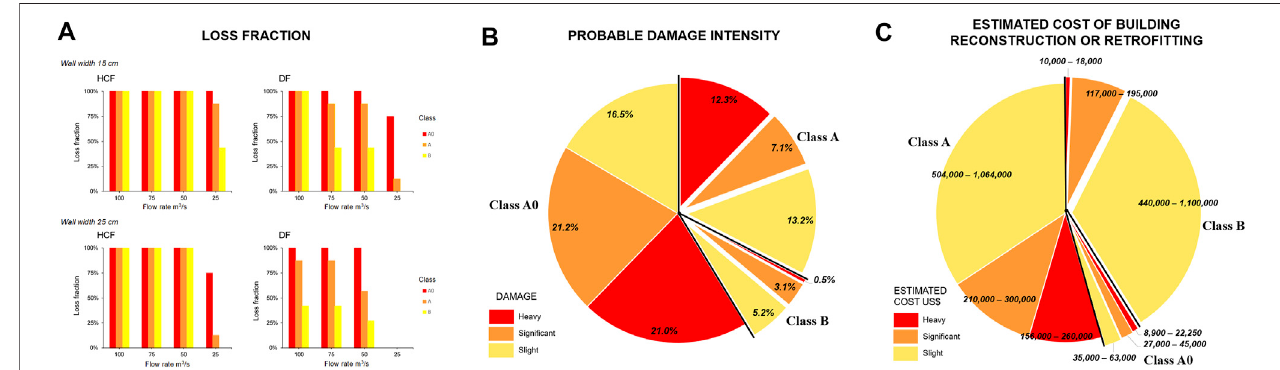
FIGURE 8 | (A) Loss fraction of buildings of classes A0, A, and B in case of DF and HCF for two wall widths of 15 and 25 cm (adapted and expanded from Mead et al.,2017). Weexpanded the2017 studyto all buildings located alongboth sidesofboth ravines under study within adistanceof50 m (maximum100 m) from and an elevationof5 m(maximum10 m)abovethechannel.NumbersofbuildingsinclassA0=249,classA=138,andclassB=37. (B) Probabledamageintensityconsidered three levels of damage: slight(impacts on walls, external elements, and roofs), signi fi cant (structural de fi ciency), and heavy (collapse) according to the location with respect to the channel and delineated area of dynamic pressure ( Figures 4C , 5C , 8 ). Damaged buildings of class A0 (heavy 89, signi fi cant 90, slight 70); class A (heavy 55,signi fi cant30,slight53);andclassB(heavy2,signi fi cant13,slight22). (C) Estimatedcostofreconstructionand/orretro fi